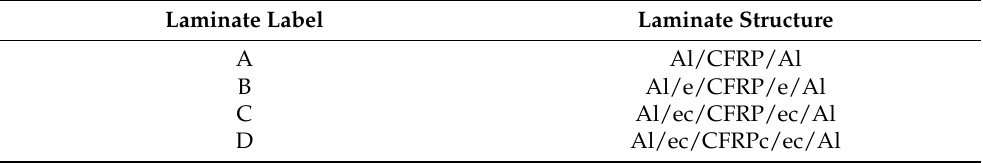
Table 1. Four different laminate structures. Laminate